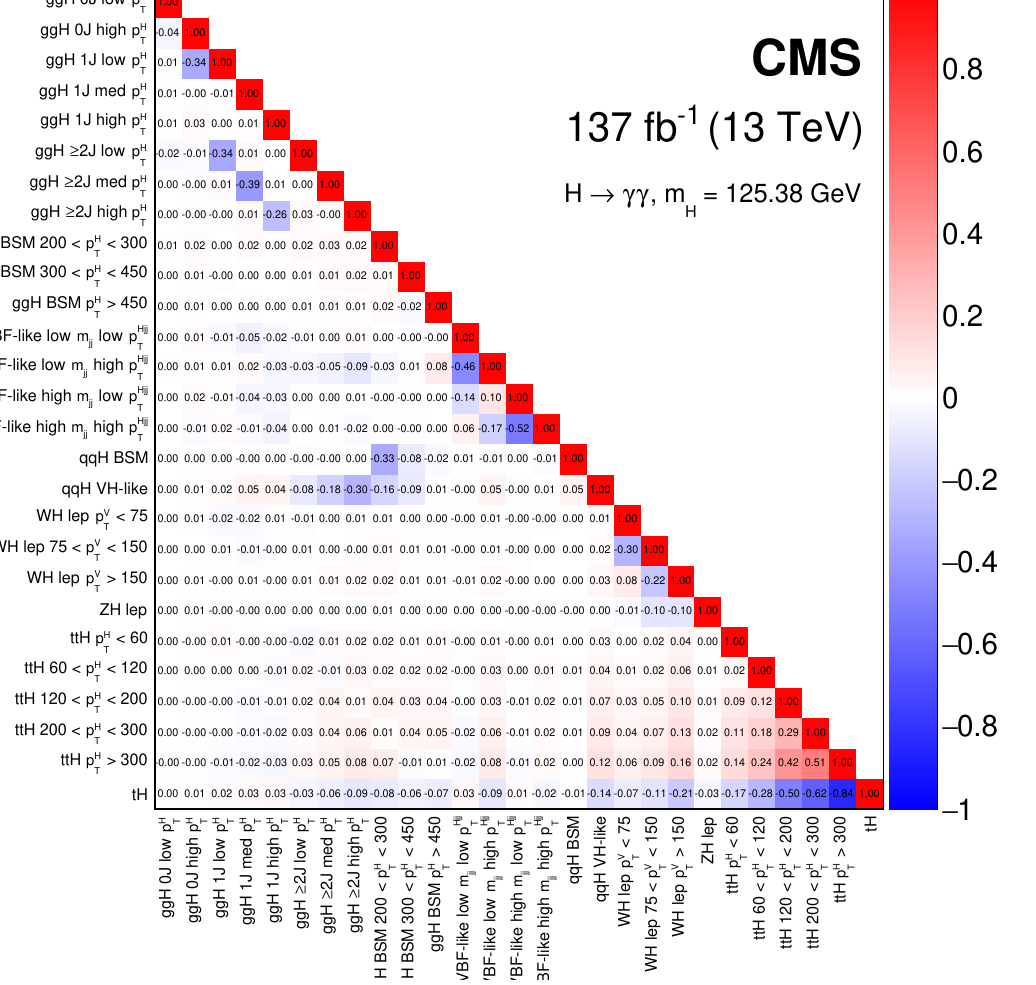
Figure 21 . Observed correlations between the 27 parameters considered in the minimal merging STXS fit. The size of the correlations is indicated by the colour